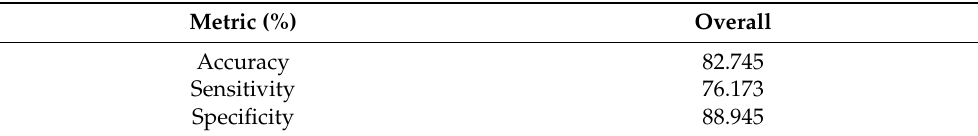
Figure 13. Normalized confusion matrix for Model A on test dataset. Table 5. Performance metrics for Model A on test dataset.